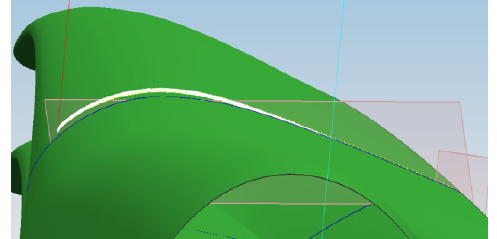
Figure 4. Fitting of profile data (in white) to CAD model (in green)